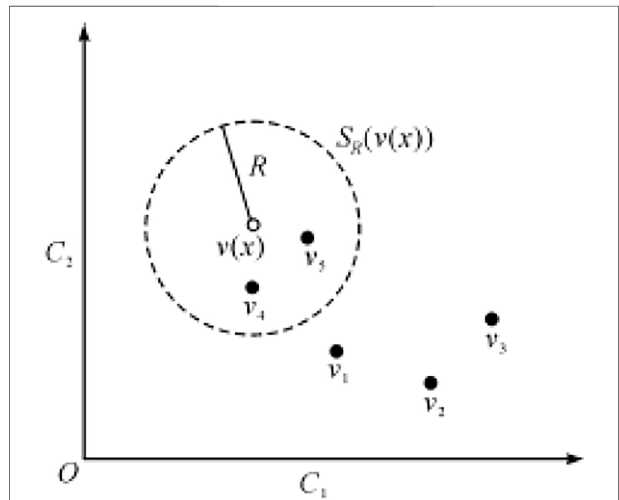
FIGURE 9 | Comparison between current frame and